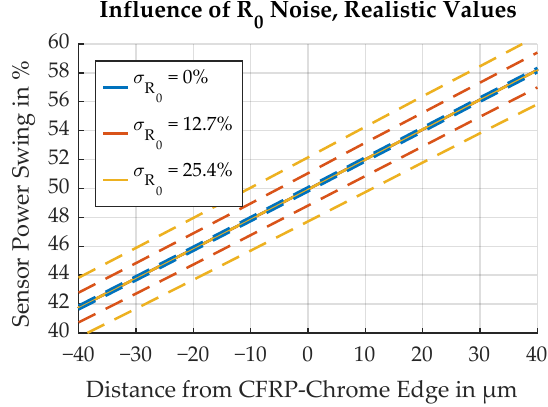
Figure 22. Demonstration of the influence of different standard deviations of the reflectivity σ R 0 on the edge transition function. Dotted lines represent ± σ .